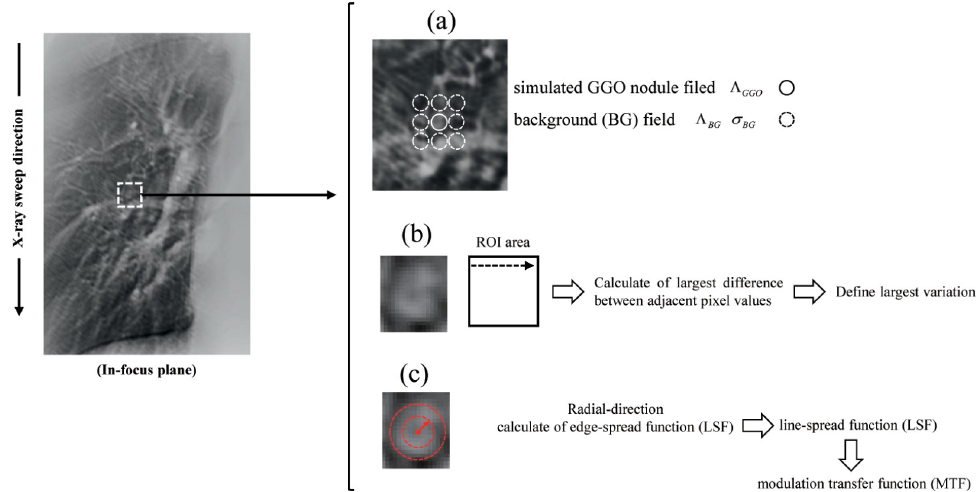
Fig 6. Assessing improvements in image quality using the Signal-Difference-to-Noise Ratio (SDNR), a statistical model with a Gumbel distribution, and the radial Modulation Transfer Function (radial MTF) of the selected features. (a) The in-focus plane image shows the simulated ground-glass opacity (GGO) nodule and background areas of the SDNR, (b) measurements and the ripple artifact with simulated GGO nodule areas of the Gumbel analysis, and (c) measurements of the simulated GGO nodule areas of the radial